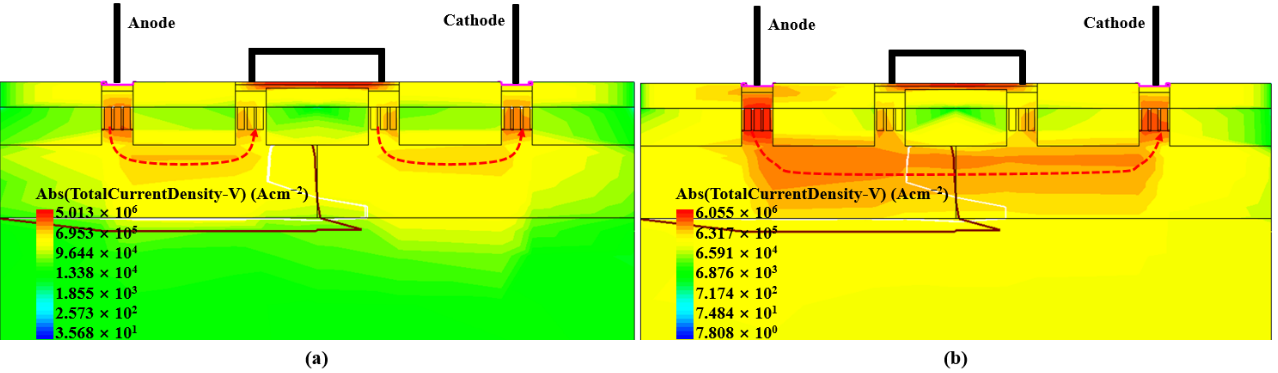
Figure 2. TCAD simulated current distribution of SCR ‐ D at different stages: ( a ) low ESD current; ( b ) large ESD current.